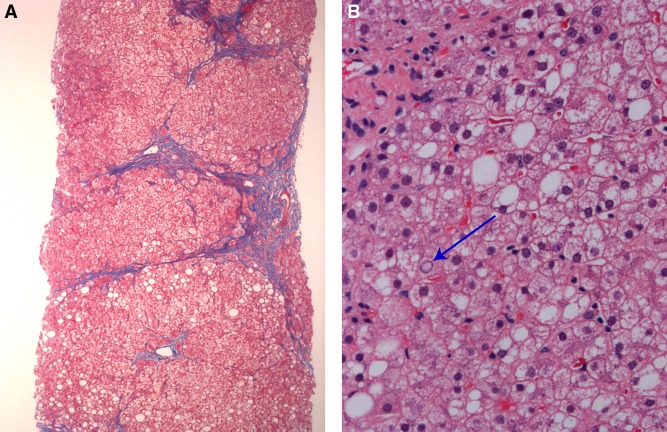
Liver biopsy showed (A) focal bridging and perisinusoidal fibrosis (trichrome stain) and (B) steatosis with glycogen nuclei (blue arrow; hematoxylin and eosin stain).